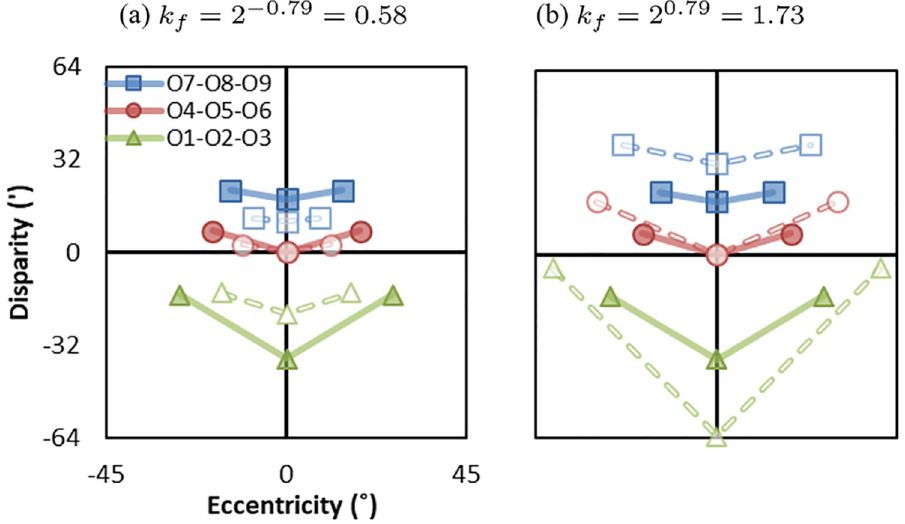
Fig 11. Effect of FOV mismatch in two conditions: (a) screen FOV is smaller than camera FOV ( k f = 0.58), and (b) screen FOV is larger than camera FOV ( k world ( E ; D ) and dashed lines represent the eccentricity-disparity in the reconstructed world ( E oc o